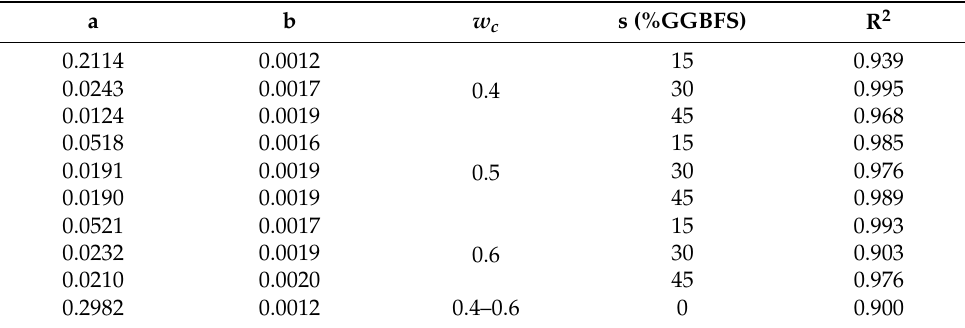
Table 7. Regression coefficients corresponding to each slag blended